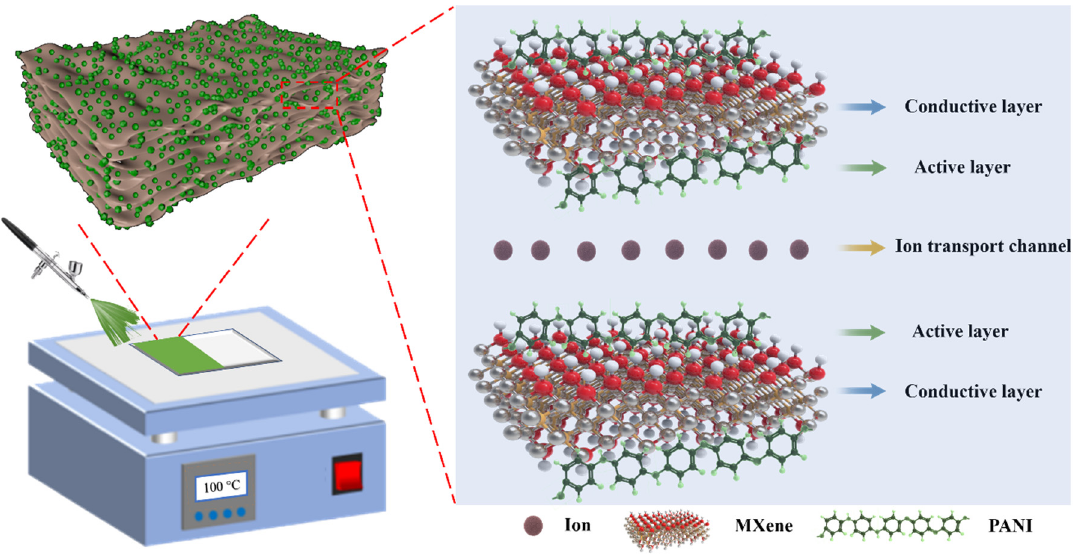
Figure 8. Schematic of the nanostructure of PANI/MXene for the electrochromic electrode.